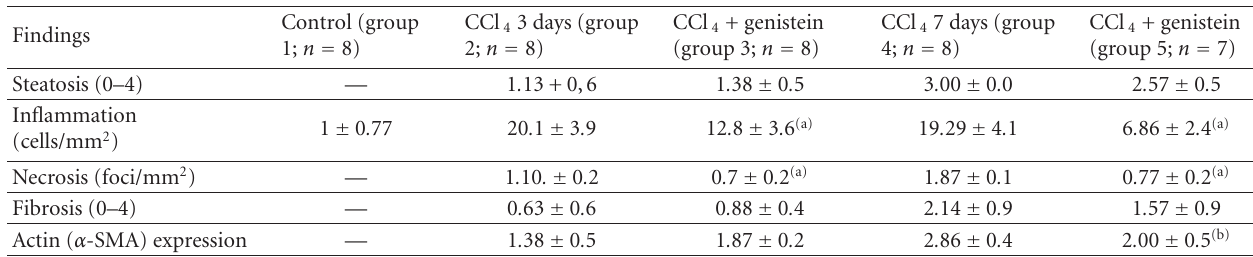
Table 2: Results of histopathological